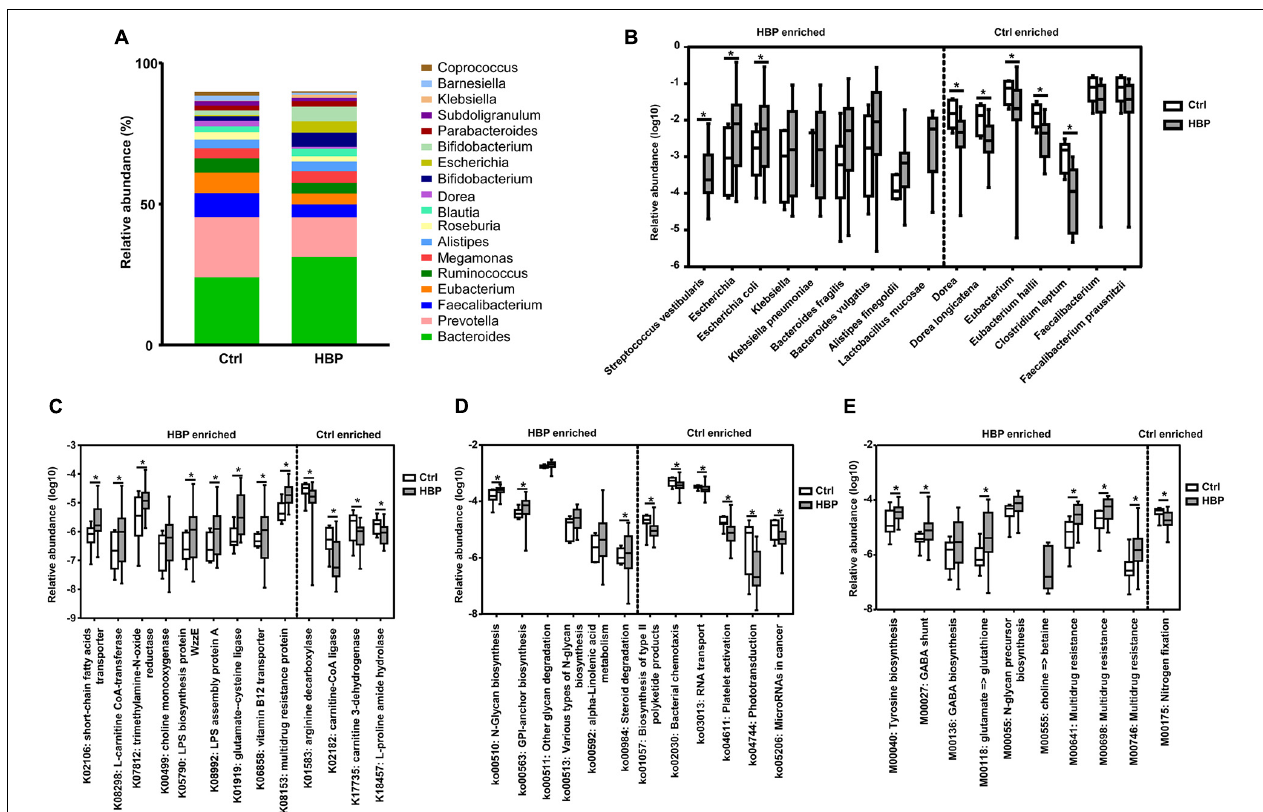
FIGURE 2 | Microbiome abundances at different levels show significant differences between healthy control and primary hypertension patients with antihypertension medications. (A) The relative abundances of the top 18 highest abundant genera in the two groups. (B) The most significantly different genera and species and their relative abundances between the two groups. Nine strains enriched in patient group are shown on the left side, and seven strains enriched in control group are shown on the right side. (C) Part of the most significantly different Kyoto Encyclopedia of Genes and Genomes (KEGG) ortholog groups and their relative abundances between the two groups. (D) The most significantly different KEGG pathways and their relative abundances between the two groups. (E) The most significantly different KEGG modules and their relative abundances between the two groups. Categories enriched in control group and patient group are separately shown on the right side and left side of each graph. * p < 0.05 by two-tailed Mann–Whitney U -test. Ctrl, healthy control group. HBP, primary hypertension patient group who took antihypertension